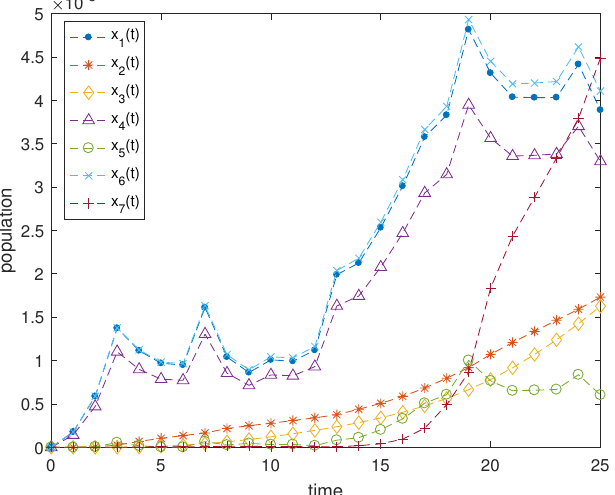
Figure 2. Temporal profiles of the state variables of Sln-1-phosphorelay system in (20) at the systematic characteristic case: k 0 = 0.5, k 1 = 0.4, k 2 = 0.1, k 3 = 50, k 4 = 50, k 5 = 0.5 with v t ∼ N ( 0,0.01 2 )